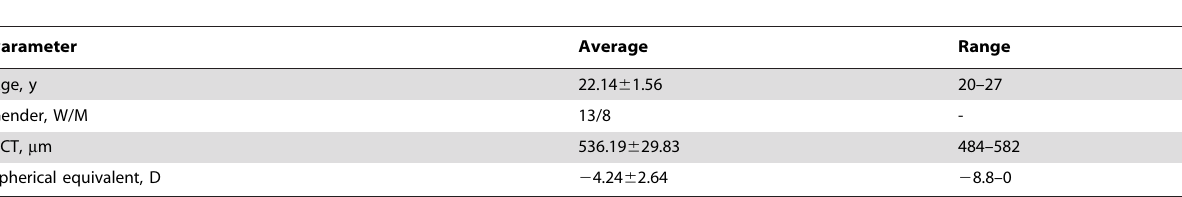
Table 1. The values are presented as the means 6 standard deviations.